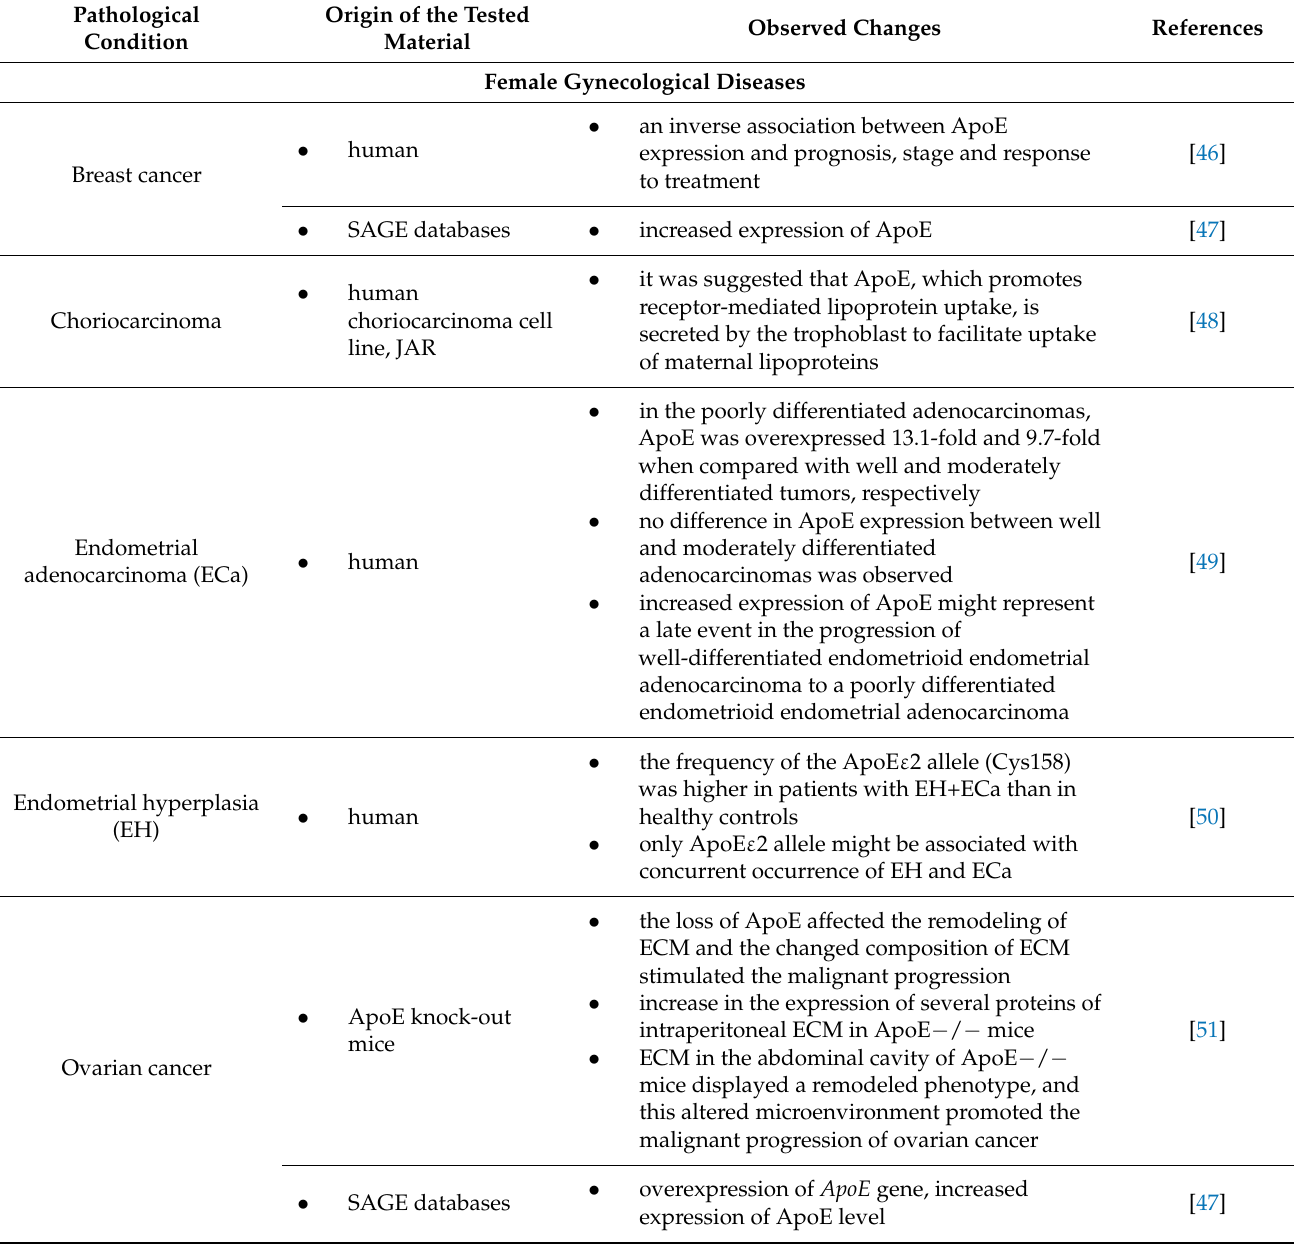
Table 1. The association of ApoE expression with other gynecological and male reproductive tract diseases, and in the context of some other types of